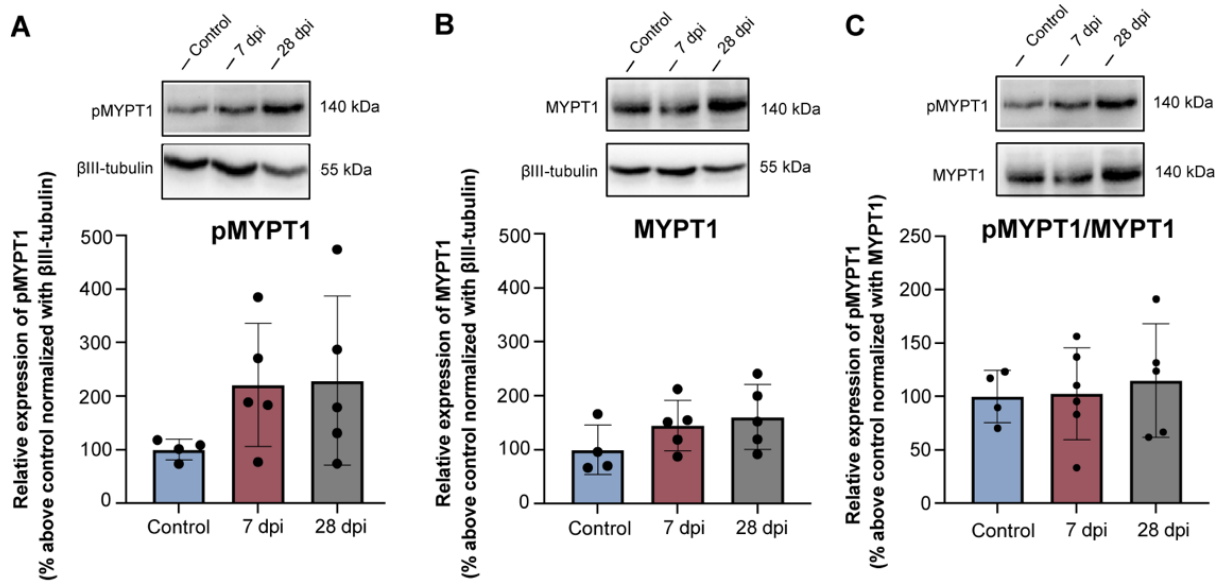
Figure 5. Time-dependent expression of MYPT1 and pMYPT1 in lumbosacral (L5-S1) DRG neurons of spinal intact (control) and SCT (7 and 28 dpi (days post-injury)) animals, determined by Western blotting. pMYPT1 ( A ) and MYPT1 ( B ) were normalized against β III-tubulin and levels of pMYPT1 were also normalized against endogenous levels of MYPT1 ( C ). In all cases, no statistical differences were found between experimental groups. Graphs represent mean ± SD. One-way ANOVA followed by Tukey’s multiple comparison test.